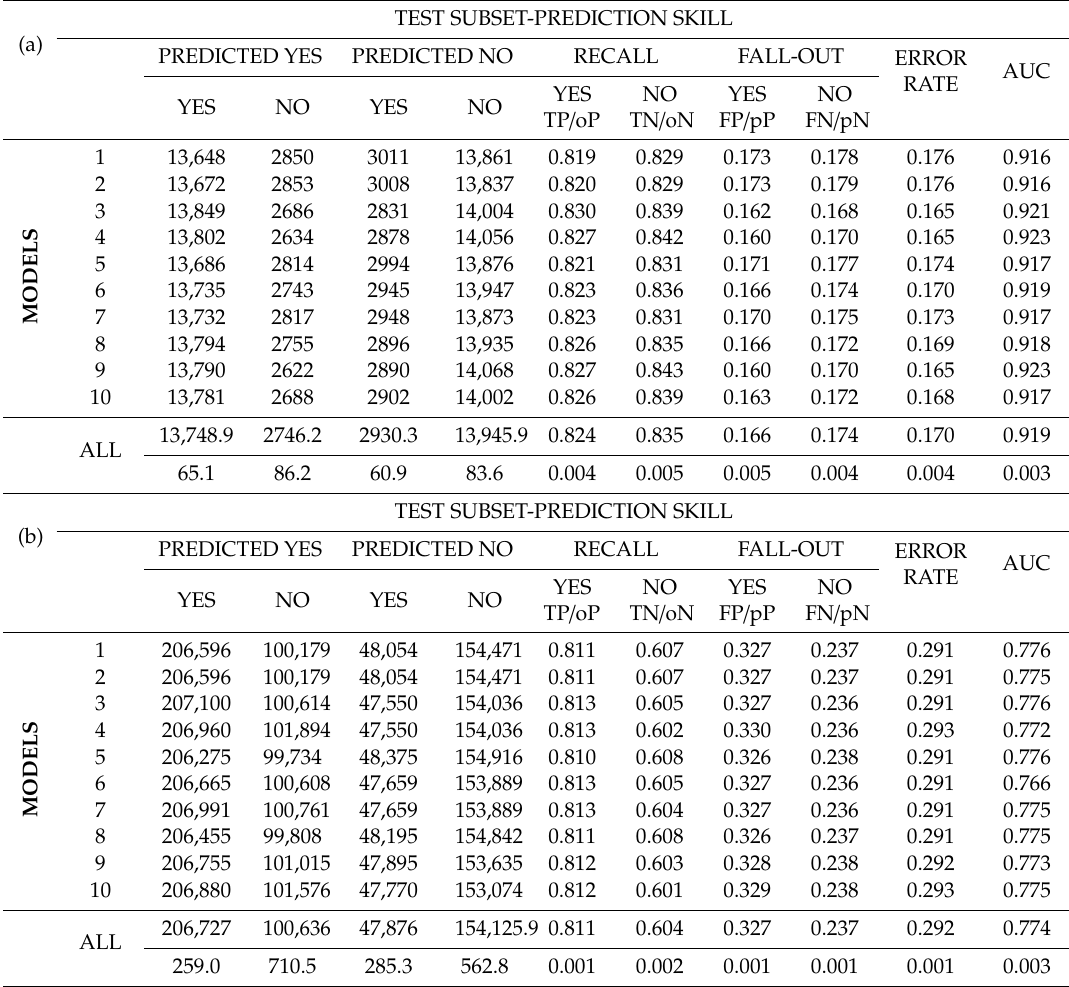
Table 4. Contingency table for the 10-model suite. a for the SCR_LSN; b for HILL_SLN. TP = true positives, TN = true negatives, FP = false positives, FN = false